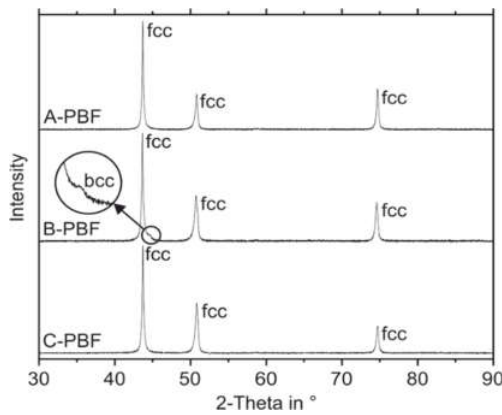
Figure 9. XRD patterns of the PBF-LB/M samples.